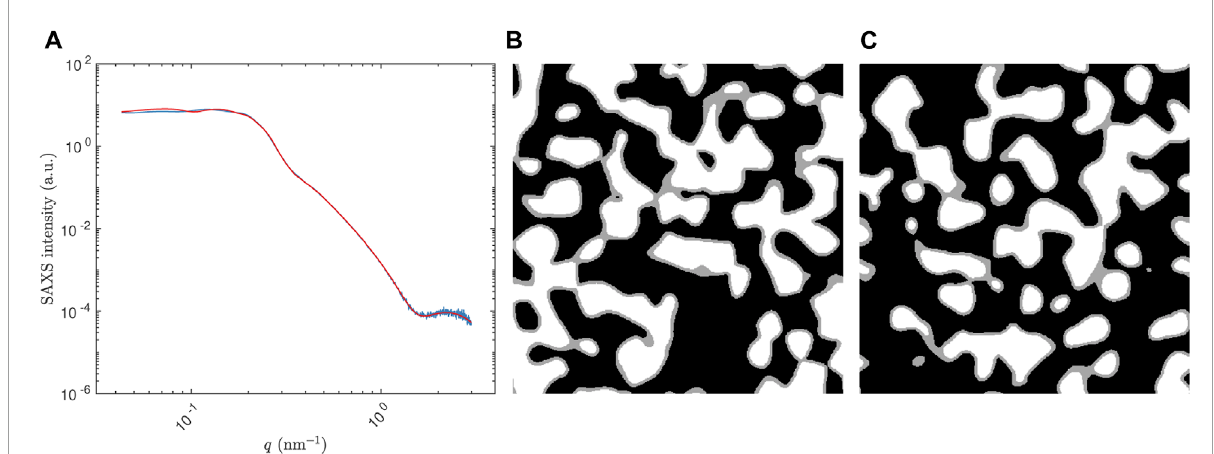
FIGURE 7 Results for a single structure in the case study. In (A) , the simulated SAXS curve for a = 4 nm, ϵ = 0 . 70, and ν = 0 . 20 (blue), and a (noiseless) SAXS curve of a structure generated using the predicted parameters ̂ a = 3 . 982 nm, ̂ ϵ = 0 . 706, and ̂ ν = 0 . 195 (red) are shown. In (B,C) , single slices from the true structure and the reconstructed structure are shown, showing pore (black), water (gray), and solid